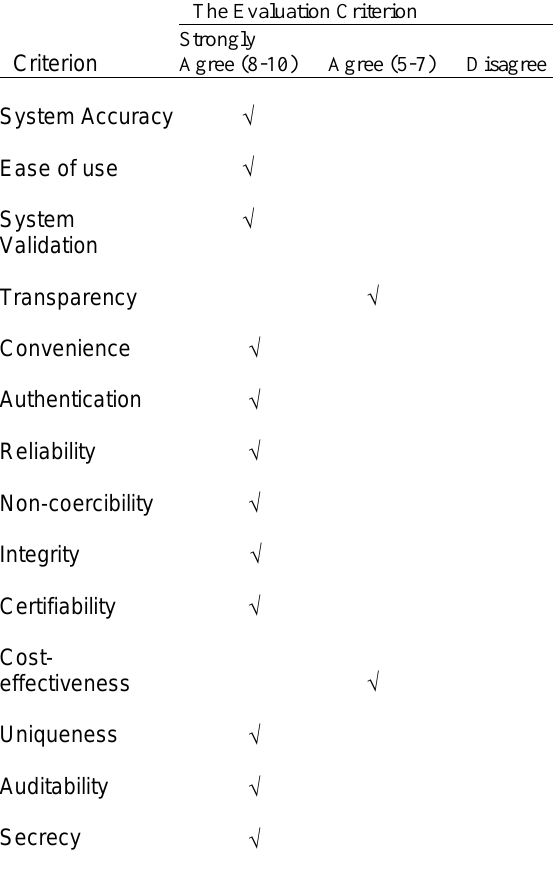
Table 1. Performance Evaluation